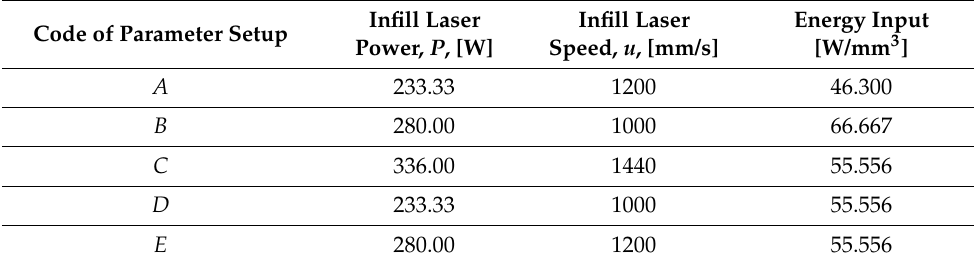
Table 1. The manufacturing parameters of the